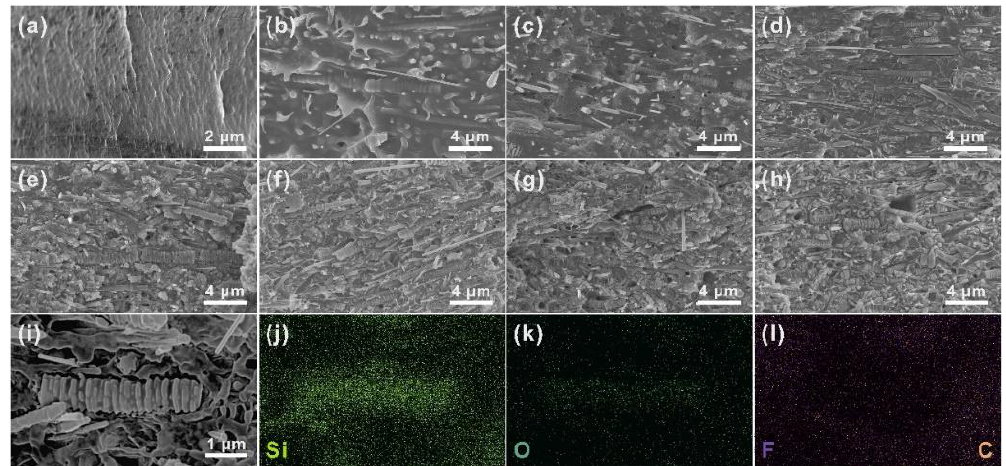
Figure 3. XPS spectra of SiC: ( a ) survey spectra, ( b ) C1S, and ( c ) Si2p; ( d ) Raman pattern of SiC.